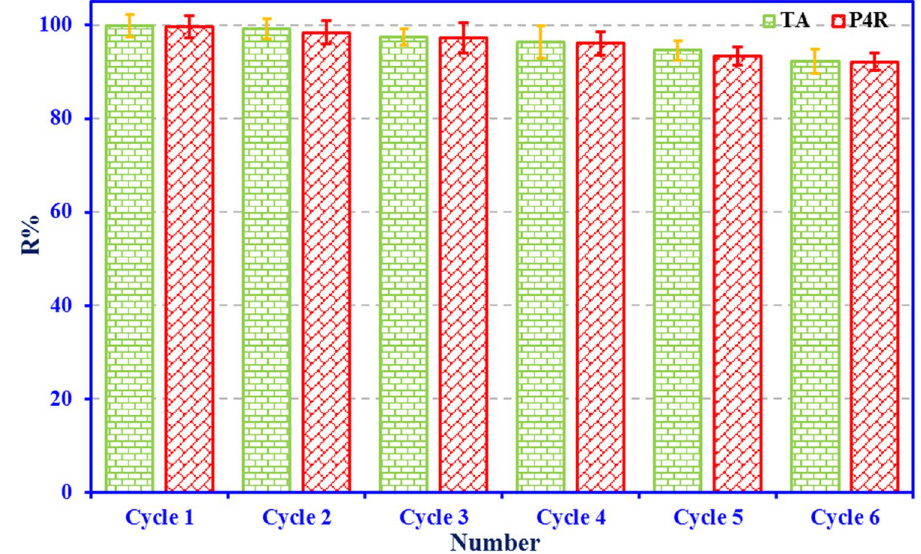
Figure 13. Cycling runs of TA and P4R removal by ZnS/CuO-CNT.